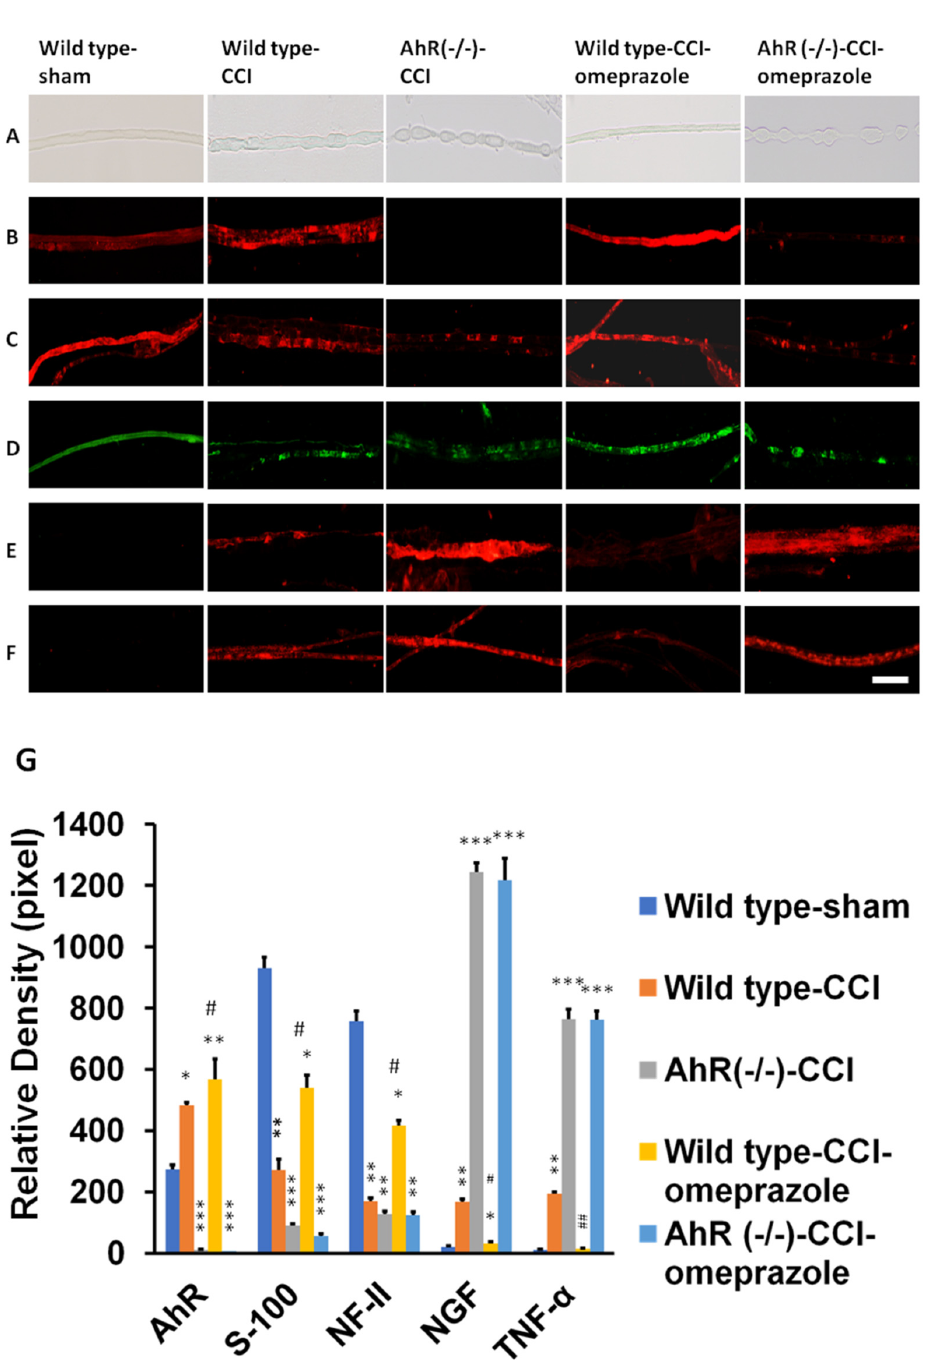
Figure 2. Modulation of AhR either by deletion or AhR agonist (omeprazole) in the nerve explant culture. Nerve explant either from wild or AhR-deleted mice was harvested and subjected to different treatment profiles observed on day-3. ( A ) Representatives of ovoid number in a light microscope related to different treatments. ( B ) Representatives of AhR in different treatments. ( C ) The expression of S-100 in different treatment groups. ( D ) The expression of NF-II in the different treatment groups. ( E ) The expression of NGF in different treatment groups. ( F ) The expression of TNF- α in different treatment groups. ( G ) The quantitative analysis of the target proteins in the different treatment groups. N = 3, Bar length = 100 µ m, omeprazole concentration: 30 µ M, *: p < 0.05; **: p < 0.01; ***: p < 0.001 indicated the value related to the group of Wild type-CCI. Wild type-sham; Wild type-CCI; AhR ( − / − )-CCI; Wild type-CCI-omeprazole; AhR ( − / − )-CCI-omeprazole: see text. # and ## indicated the value of wild type-CCI-omeprazole realtive to wild